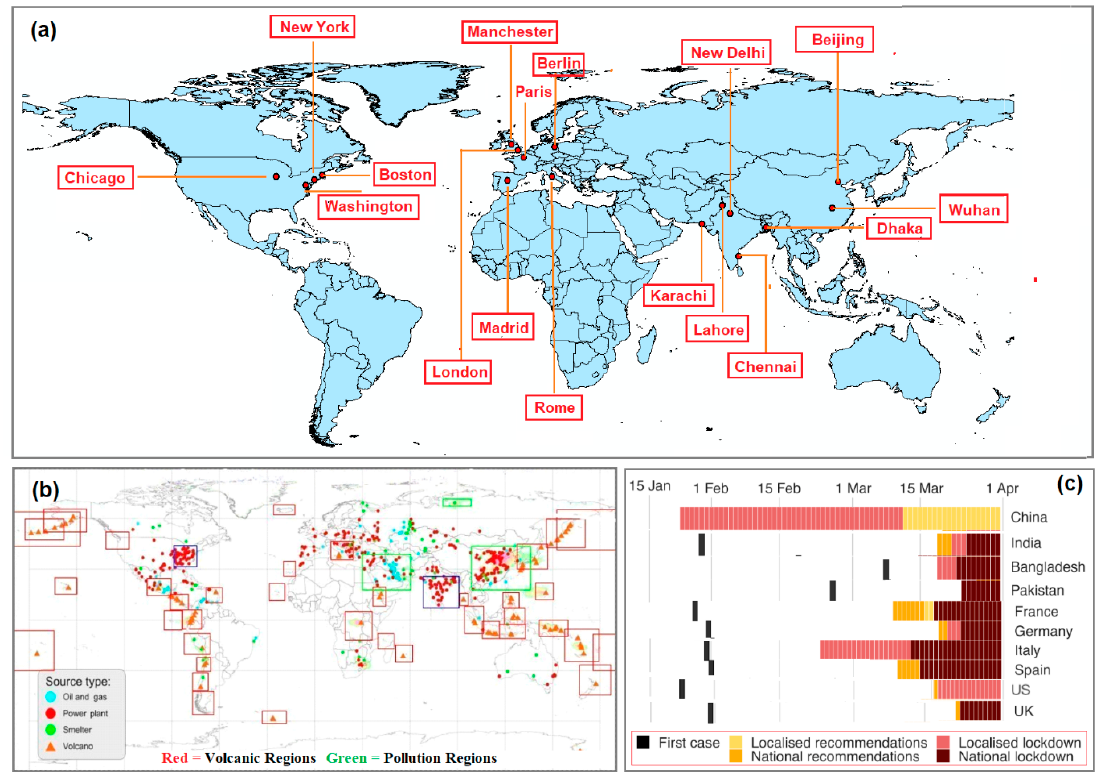
Figure 1. Illustration of study regions with some relevant details: ( a ) Locations of studied metropolitan cities, ( b ) spatial distribution of di ff erent emission sources of Sulphur, and ( c ) dates of lockdown and severity restricted internal movement by countries.